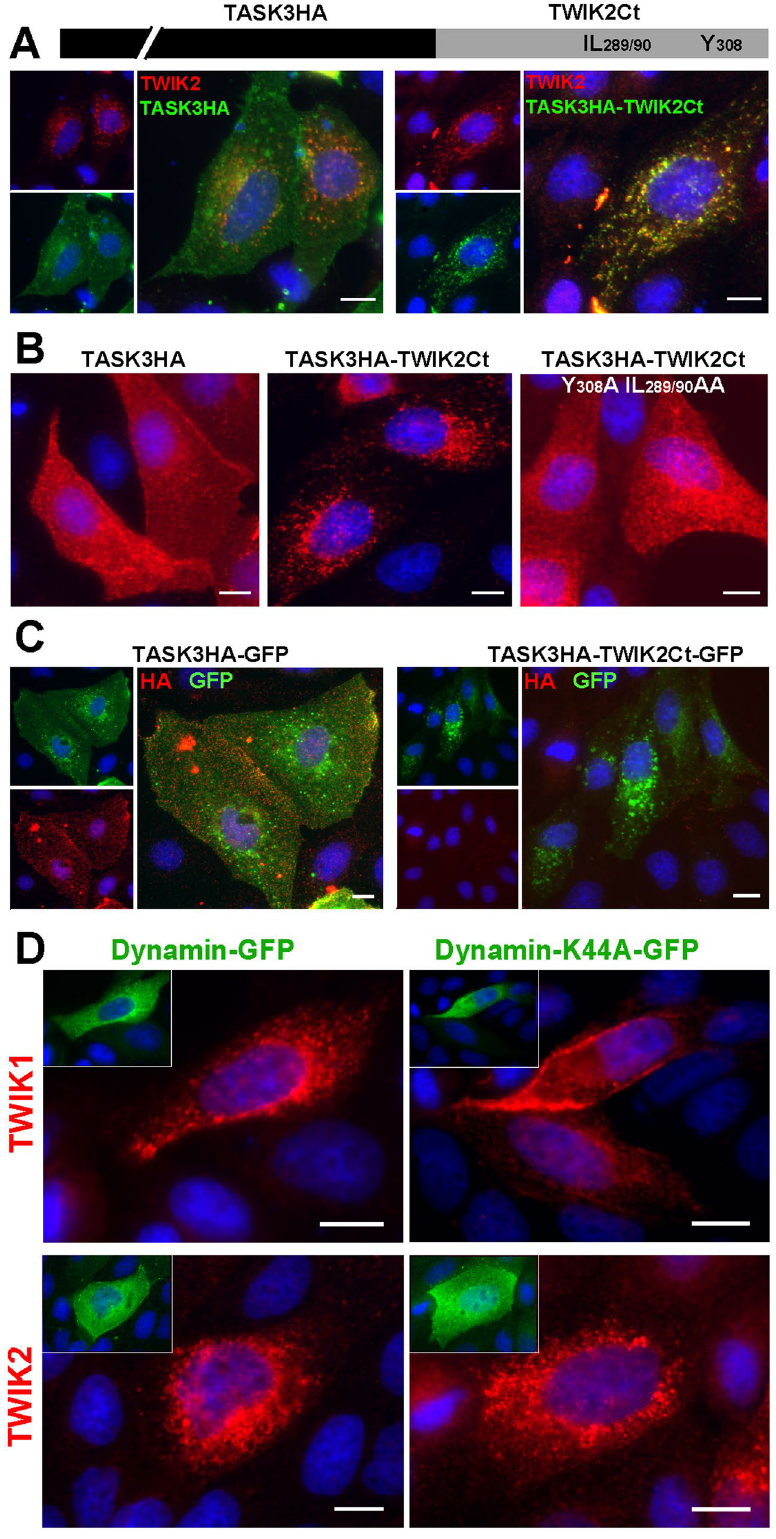
Figure 6. Cytoplasmic TWIK2 C-ter drives channel targeting to lysosomal membranes. ( A ) Co-transfection of rat TWIK2 with TASK3HA containing an extracellular HA-tag or TASK3HA-TW2Ct and staining with anti-HA (green) and anti-TWIK2 (red) antibody. ( B ) MDCK cell transfection with TASK3HA, TASK3HA-TW2Ct or TASK3HA-TW2Ct mutated at Y308A and IL289/290AA. ( C ) MDCK cell transfection with TASK3HA or TASK3HA-TW2Ct fused to GFP and stained without permeabilisation. ( D ) Co-expression of mouse TWIK1 or rat TWIK2 with Dynamin-GFP or Dynamin-K44A-GFP. Scale bar: 10 µ